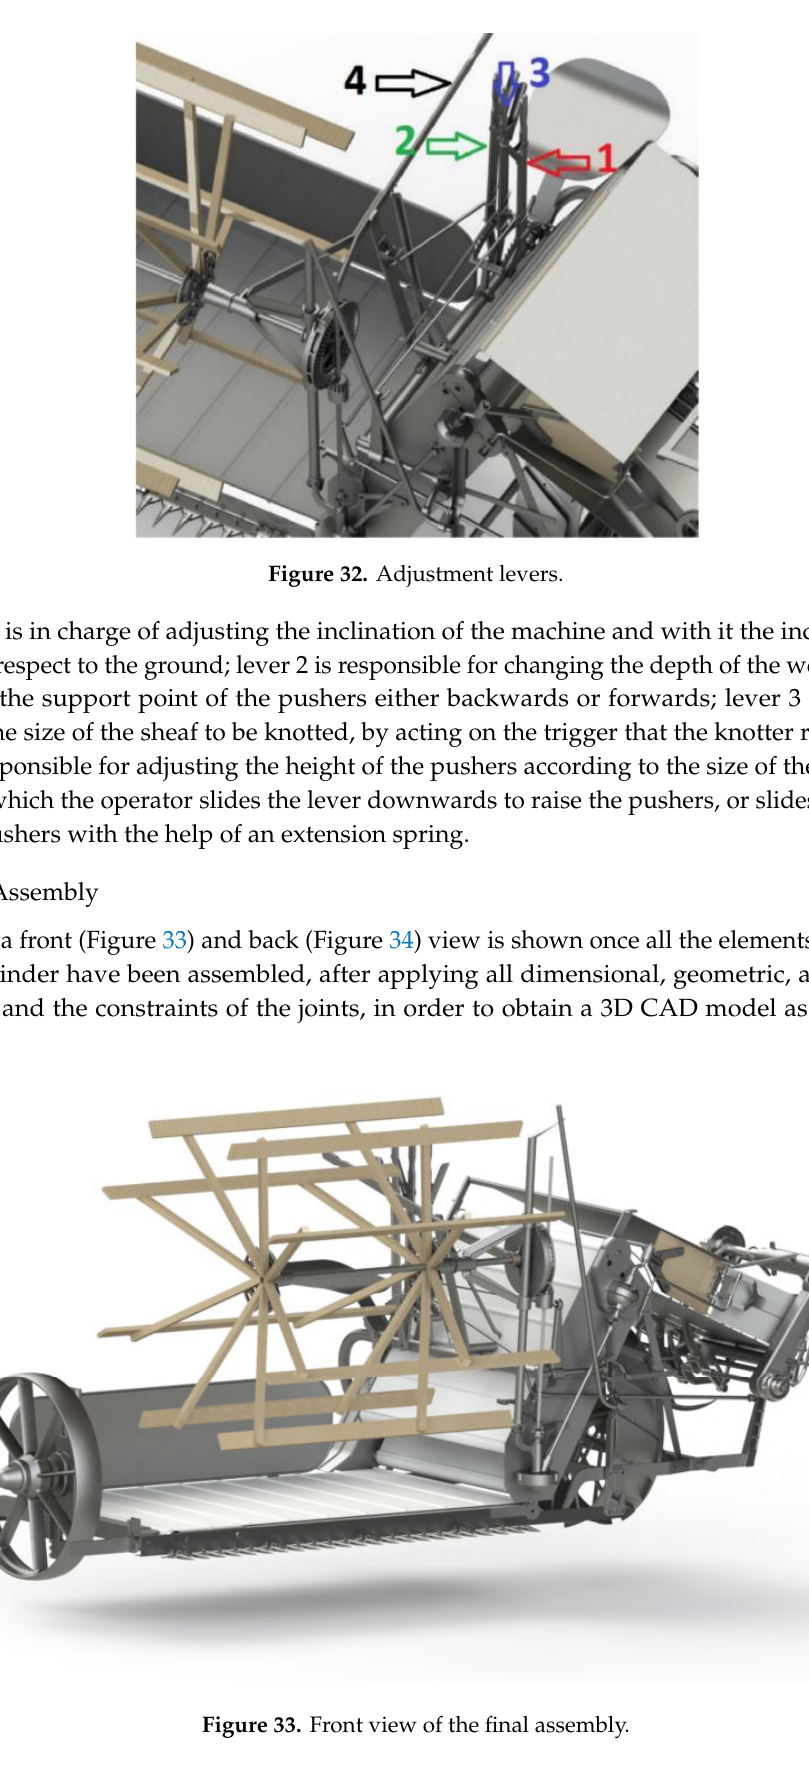
Figure 33. Front view of the final assembly.